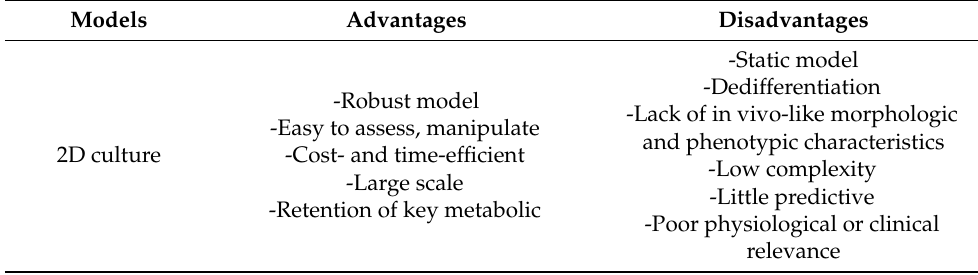
Table 2. In vitro 2D vs. 3D renal models of drug-induced